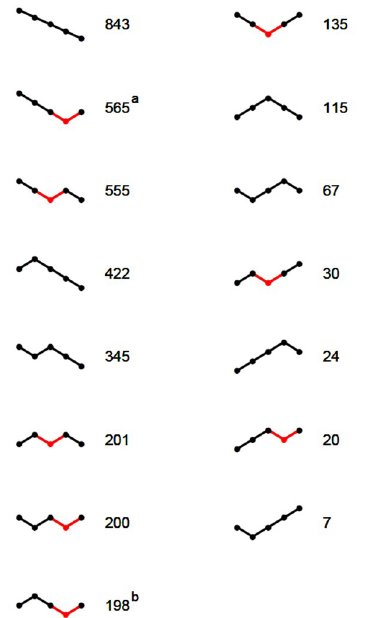
Figure 3. The 15 types of SLR models that best described the weight curves with each type characterized by a sequence of positive and negative slopes. The number found of each type is shown. Breakfast Canyon segments are shown in red—in some cases (a: 174; b: 35) it was extended by one segment to the left (not shown in red).